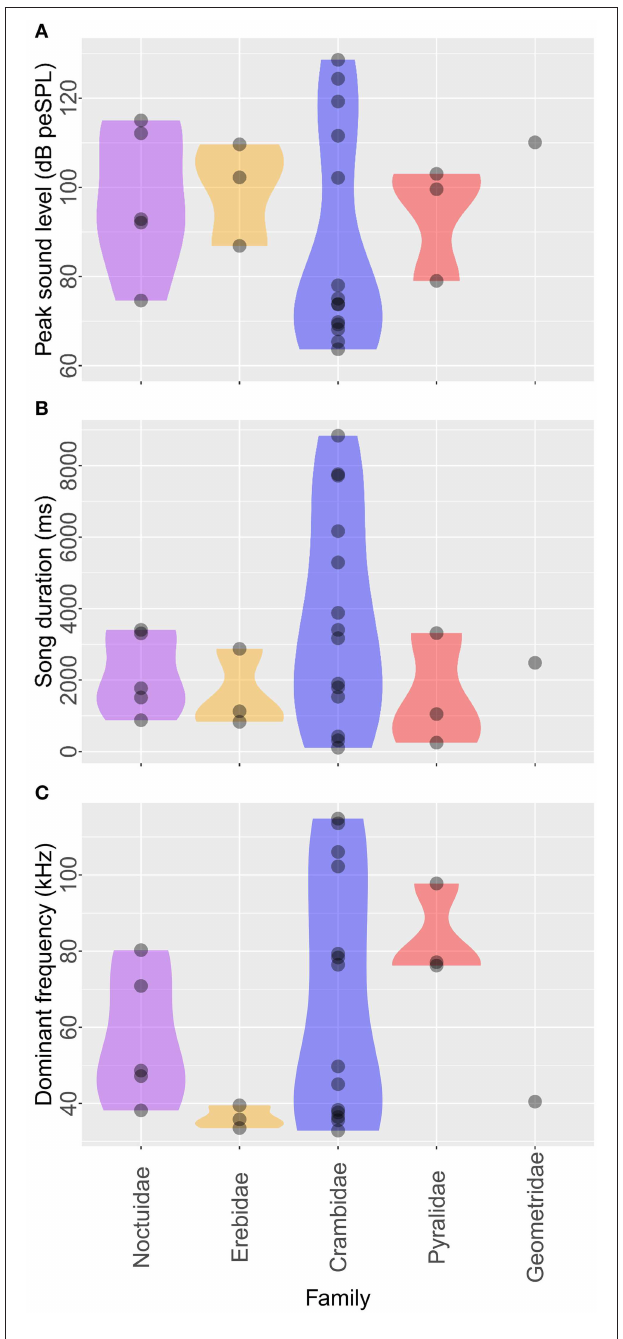
FIGURE 3 | Acoustic characteristics of male ultrasonic courtship songs in each moth family. Peak sound level (A) and song duration (B) do not differ among the five moth families but dominant frequency (C) differs among them. In these violin plots, the upper and lower limits indicate the minimum-to-maximum range, and the width indicates the relative frequencies of the data points.